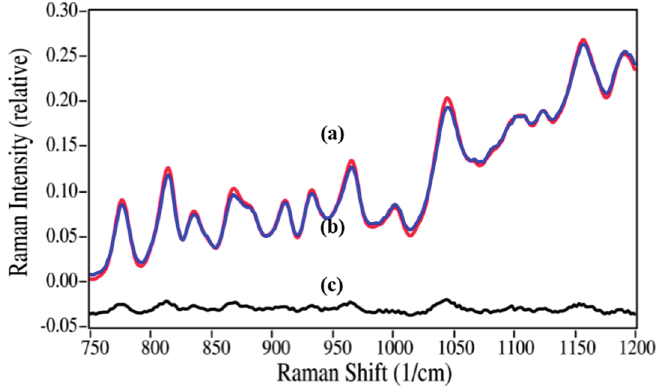
Figure 8. Raman spectrum of ( a ) the 5%/95% azaerythromycin A/azithromycin mixture (red) fit with ( b ) a spectrum created using 4.3% azaerythromycin A and 95.7% azithromycin of their pure spectra; ( c ) The residual of the fit ( a–b ). Spectral conditions as in Figure 6, except 565 to 1220 cm − 1 region